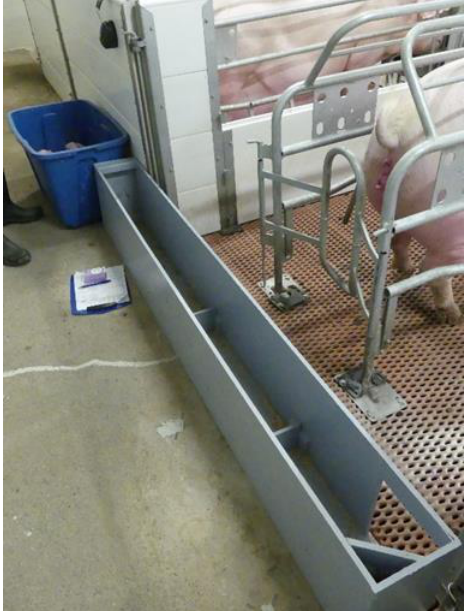
Figure 1. A picture of the navigation chute placed at the back end of the farrowing crate. The blue container at top left is a holding container for piglets prior to placement in the chute. Piglets are placed to start chute navigation in the section closest to this container. Two hurdles visible along the length of the chute, which piglets step over in order to exit the chute. At bottom right is the opening where piglets exit back into the farrowing crate.